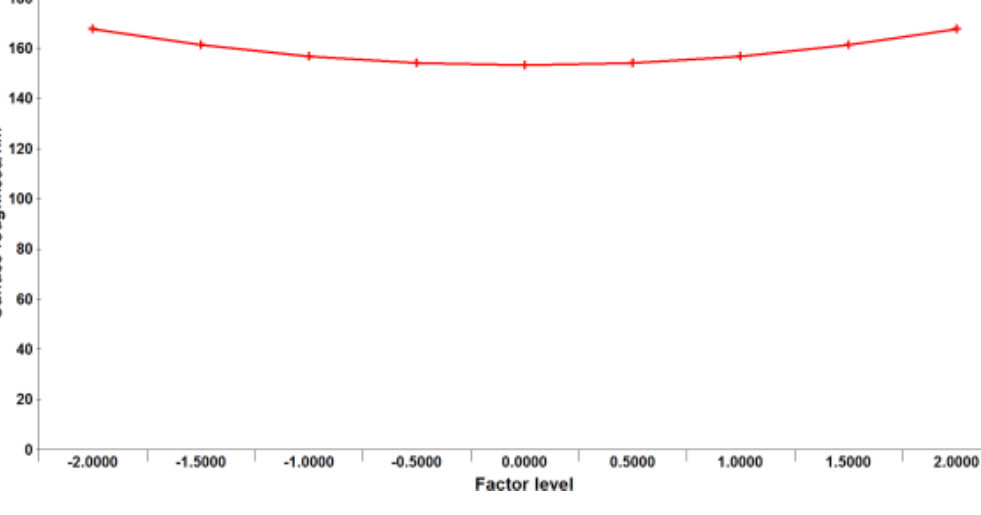
Figure 10: The effect of duty cycle on surface roughness